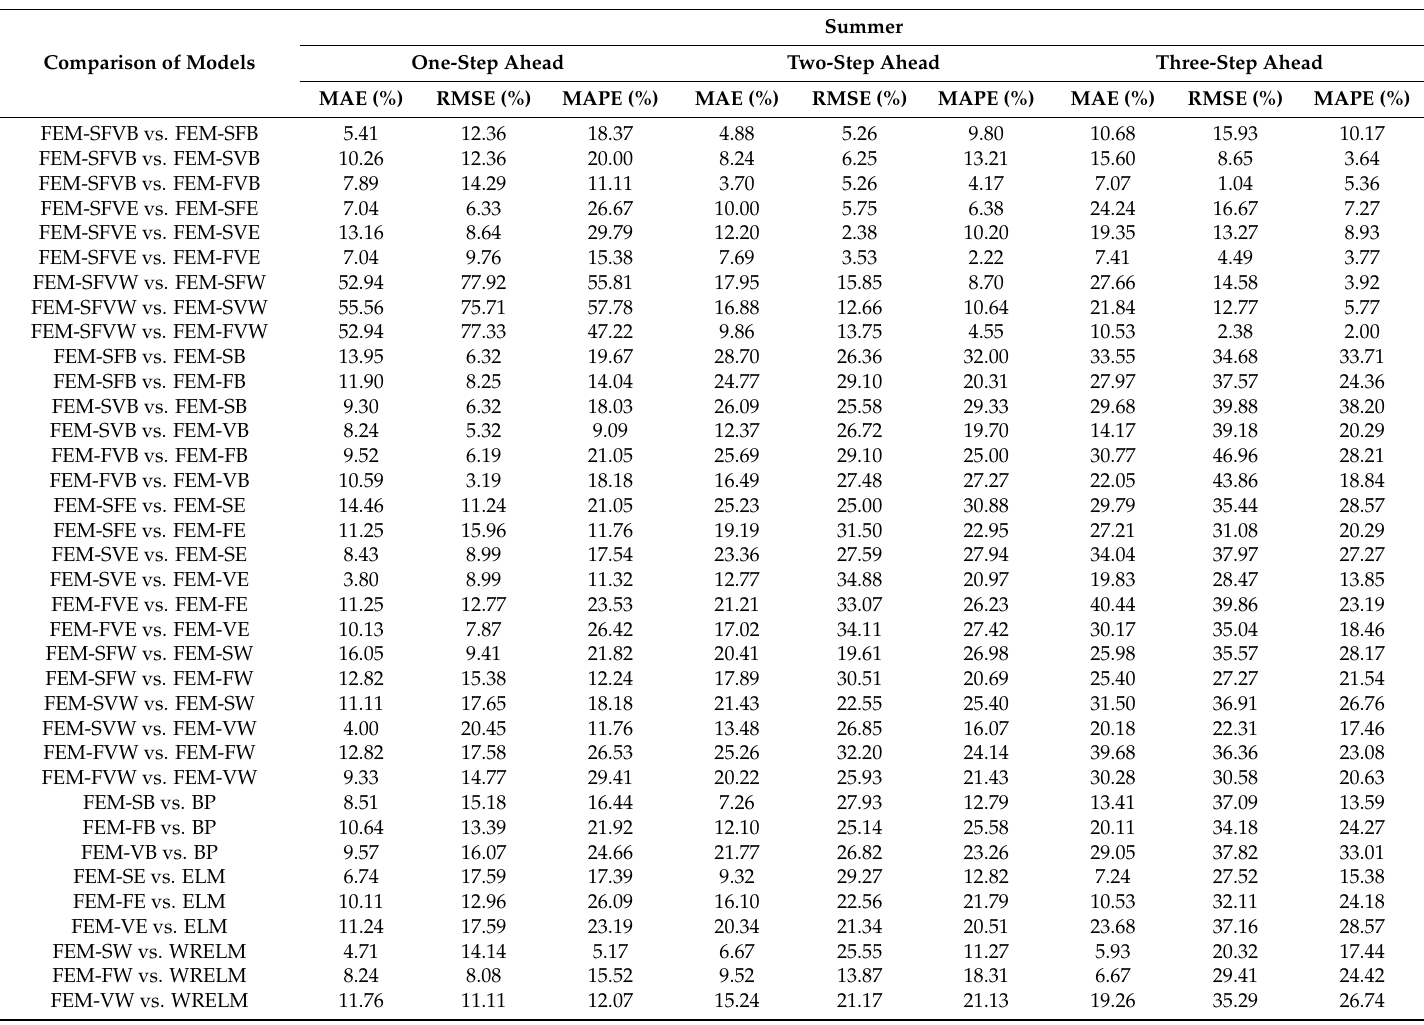
Table 12. Comparison results of experiments III, IV and V in